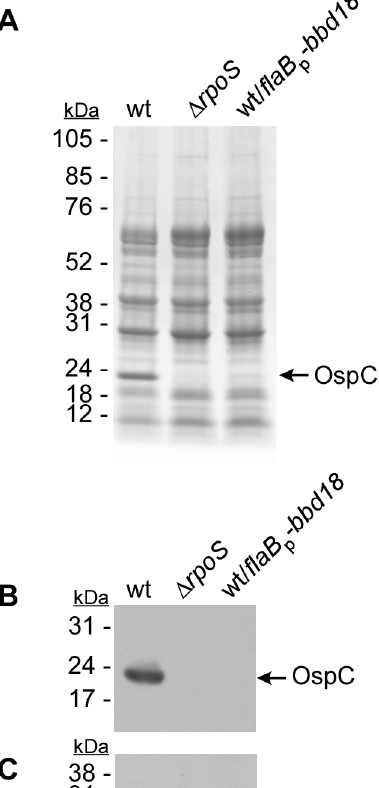
Figure 1. Effect of BBD18 on proteins in the RpoS regulon. B. burgdorferi strains B31-S9 (wt), B31-S9 D rpoS ( D rpoS ) and B31-S9/ pBSV2*- flaB p- bbd18 (wt/ flaB p- bbd18 ) were grown under rpoS -inducing conditions (BSKII medium, pH 6.8). Cell lysates were subjected to SDS- PAGE, Coomassie blue staining (A), and immunoblot analysis (B-G). Membranes were probed for the presence of OspC (B), BBD18 (C), BBA66 (D), or DbpA (E), using protein-specific antibodies or antisera. Pooled sera from mice infected with B. burgdorferi by tick bite was used to detect changes in the antigenic protein profile (F). A mouse monoclonal a -flagellin antibody (H9724) was used to detect flagellin as a protein loading control (G). Positions of molecular mass standards are shown on the left in kiloDaltons